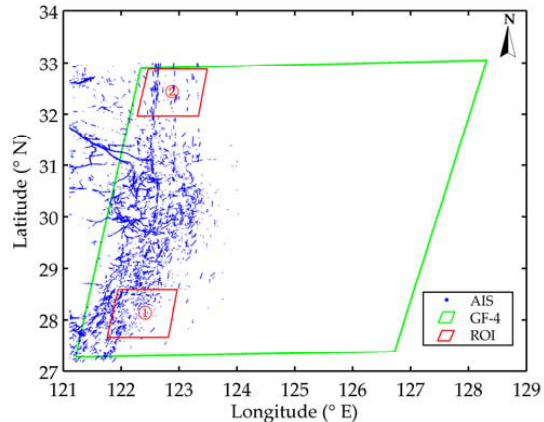
Figure 3. Coverage area of GF-4 satellite image with AIS data. The locations of AIS reports are marked by blue dots. The imaging area is bounded by green lines while two ROIs are bounded by red lines. ROI 1 and ROI 2 are labeled with ① and ② , respectively.